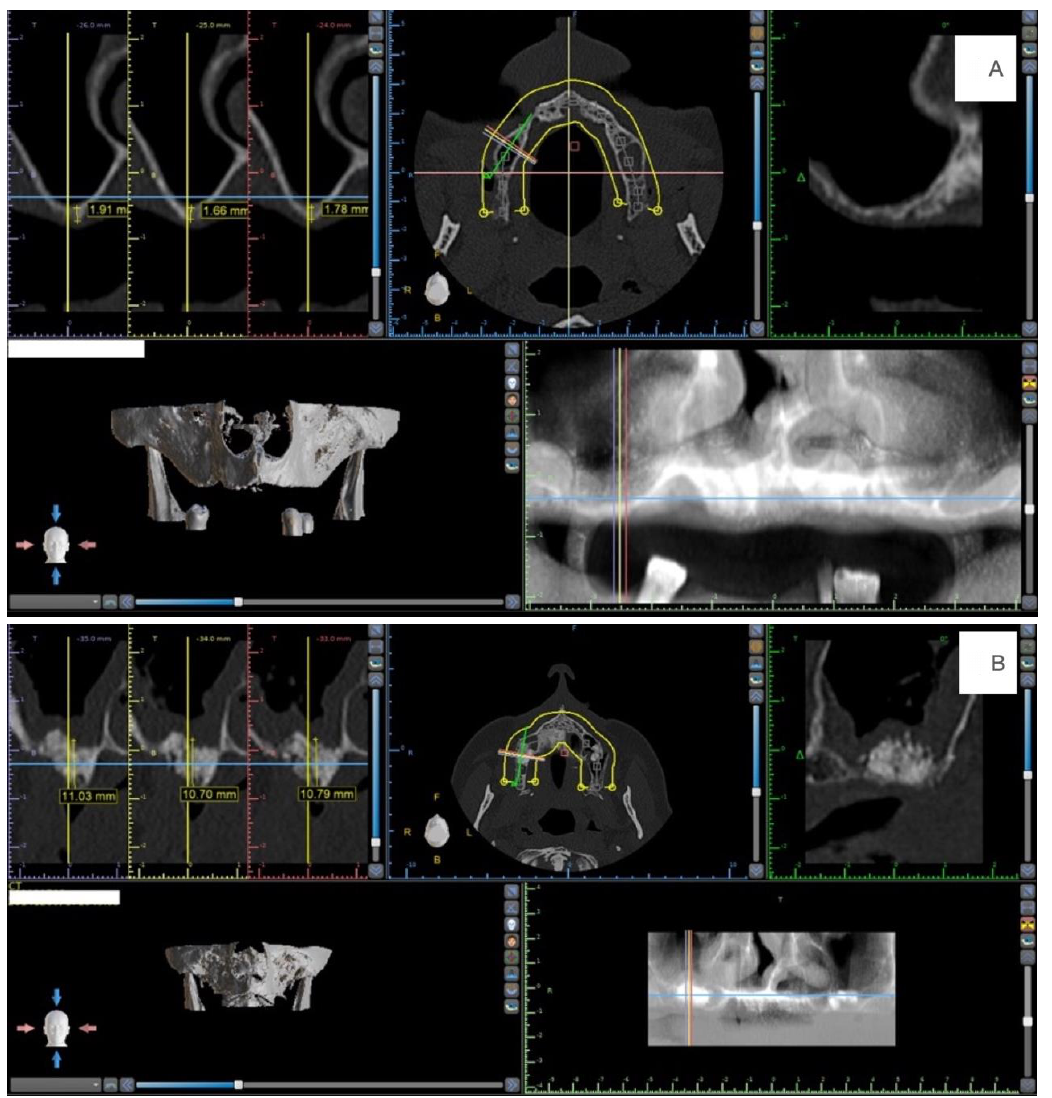
Figure 1. ( A ) Example of the measurements at the baseline. ( B ) Example of the measurements at the 6 months.